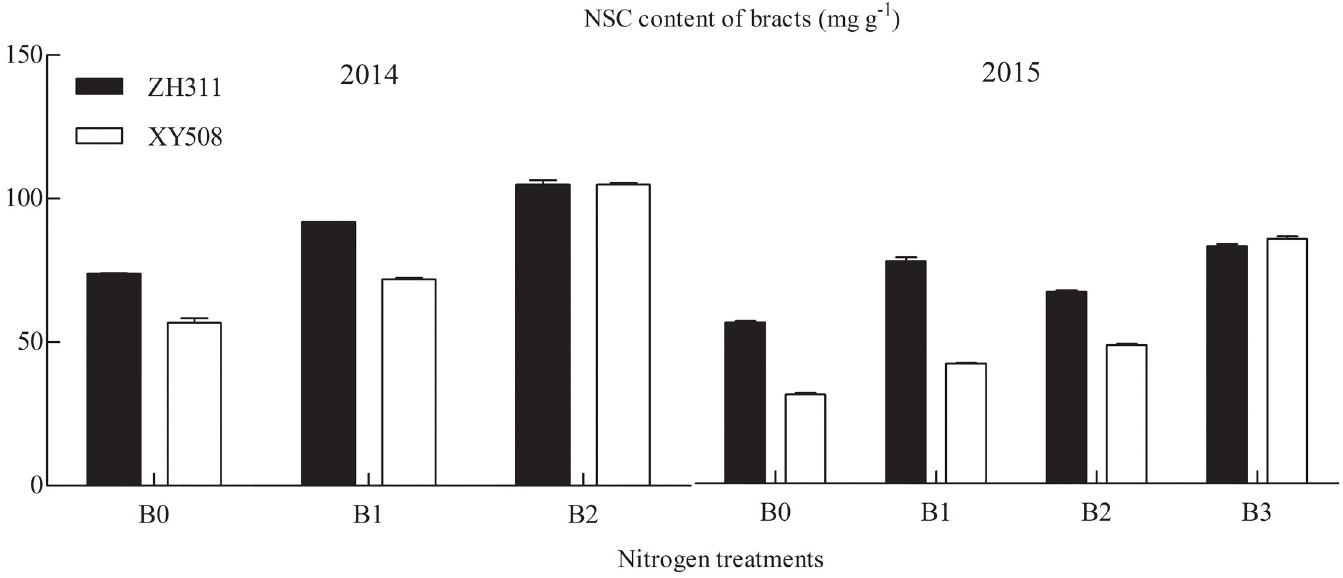
Fig 8. NSC contents of bracts under different nitrogen treatments. Note: B0-0 kg � ha − 1 ; B1-150 kg � ha − 1 ; B2-300 kg � ha − 1 ; B3- 450 kg � ha − 1 .